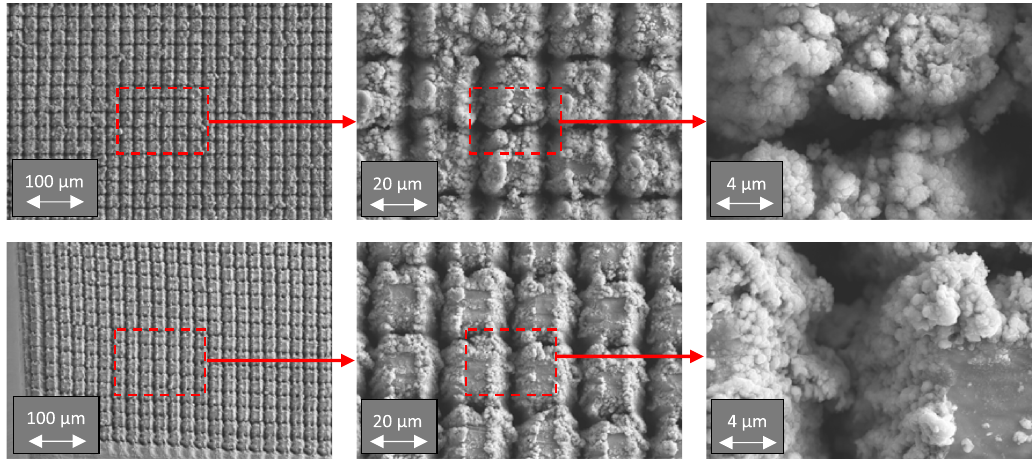
FIG. 11. SEM images at different magnifications of a CH reference sample produced at the University of Dundee (top row) and of a twin sample after cleaning with ultrasonic agitation for 5 minutes (bottom